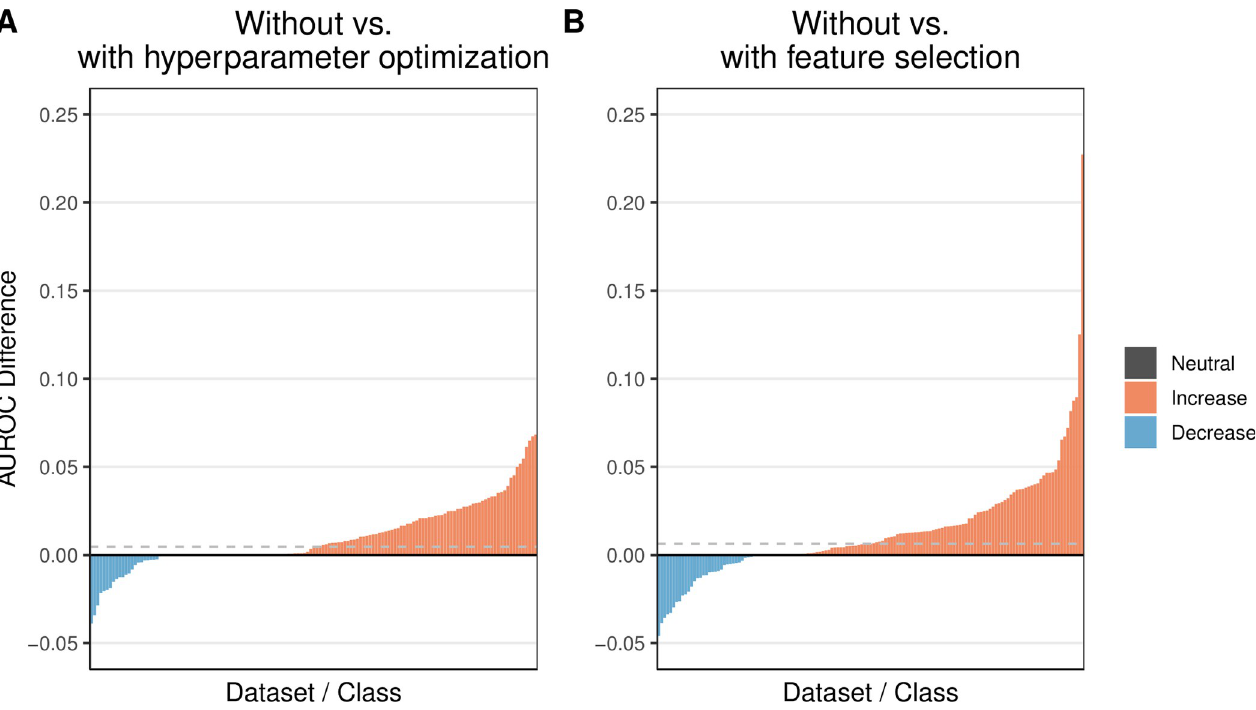
Fig 5. Relative predictive performance when using default algorithm hyperparameters and all features vs. tuning hyperparameters or selecting features. In both A and B , we use as a baseline the predictive performance that we attained using default hyperparameters for the classification algorithms (Analysis 3). We quantified predictive performance using the area under the receiver operating characteristic curve (AUROC). In A , we show the relative increase or decrease in performance when tuning hyperparameters within each training set (Analysis 4). In most cases, AUROC values increased. In B , we show the relative change in performance when performing feature selection within each training set (Analysis 5). AUROC increased for most dataset / class-variable combinations. The horizontal dashed lines indicate the median improvement across all dataset / class-variable combinations.